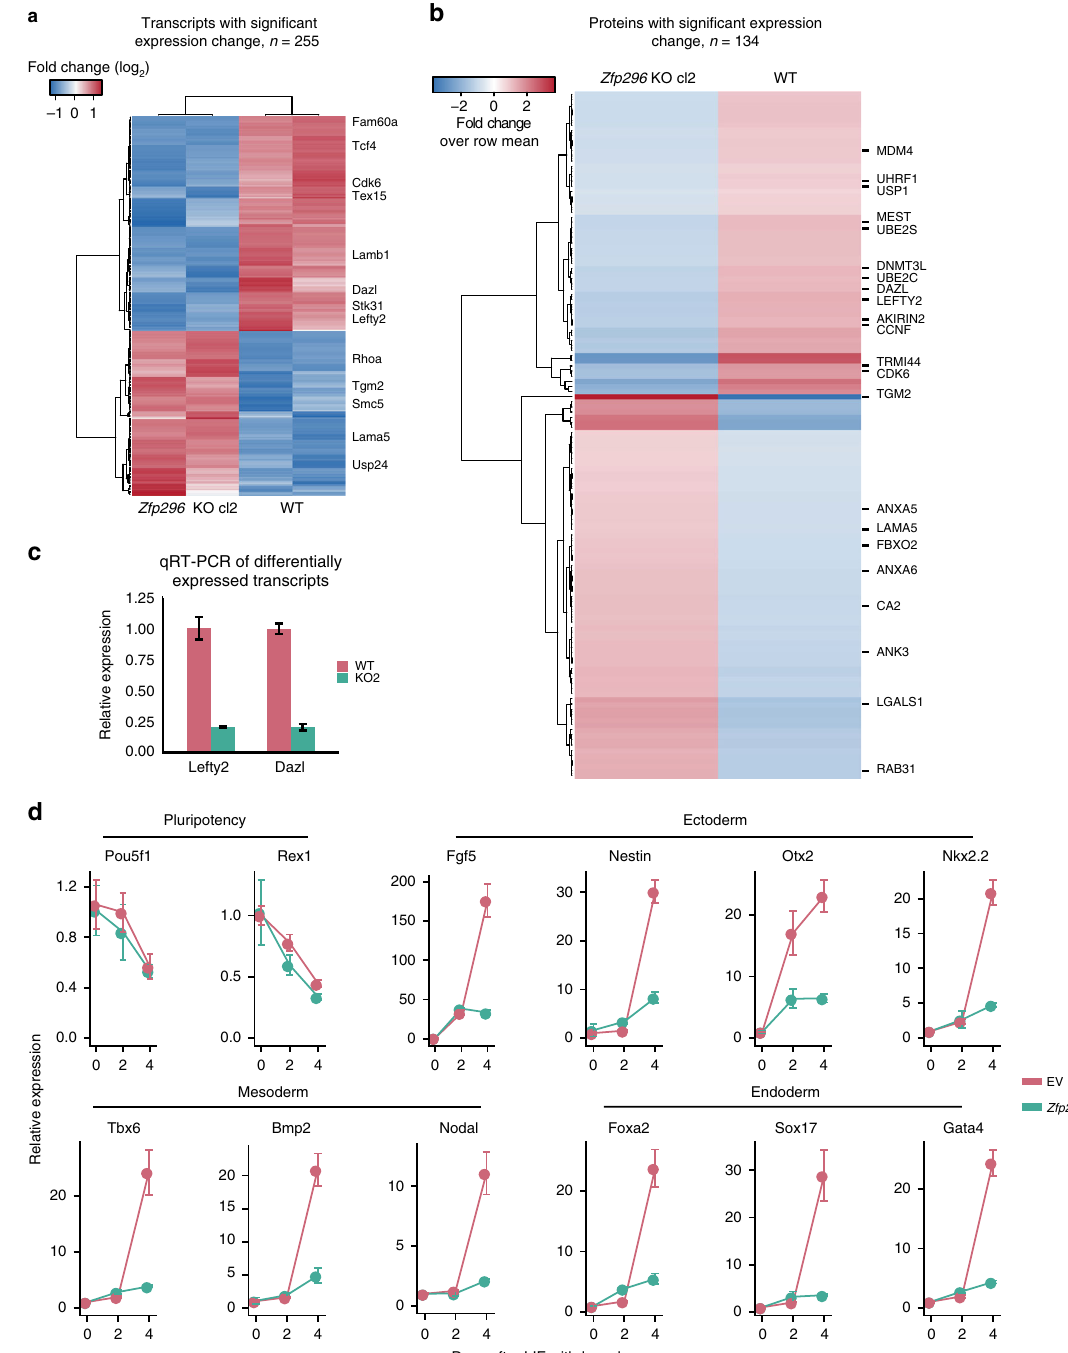
Fig. 5 Zfp296 knockout does not affect steady-state gene expression but impairs ESC differentiation. a Hierarchical clustering of differentially expressed genes (padj < 0.05) in Zfp296 KO clone 2 ESCs compared to wild-type (WT) ESCs. b Hierarchical clustering of differentially expressed proteins in Zfp296 KO clone 2 ESCs compared to WT ESCs. c qRT-PCR validation of differentially expressed transcripts in WT and Zfp296 KO clone 2 ESCs. n = 2 RNA isolations, error bars = s.d. of technical triplicates from one experiment. d qRT-PCR analysis of expression levels of pluripotency and differentiation markers during an embryoid body (LIF withdrawal) time course using WT and Zfp296 KO clone 2 ESCs. n = 4 time courses, error bars = s.d. of technical triplicates from one (PX459; Addgene 48139). The resulting plasmid was veri fi ed by sequencing and Chromatin preparation . Attached ESCs and NPCs were cross-linked with 1% transfected into R1 ESCs. After two days, the cells were subjected to puromycin formaldehyde for 10 min at room temperature with gentle shaking. Cross-linking selection for 48h, then monoclonal cell lines were generated and analyzed by was quenched with the addition of 1/10 volume 1.25 M glycine. Cells were washed sequencing. with PBS, then harvested by scraping in Buffer B (20 mM HEPES, 0.25% Triton X- Wild-type and Zfp296 KO ESCs were differentiated into embryoid bodies by 100, 10 mM EDTA, and 0.5mM EGTA). Cells were pelleted by spinning at 600× g plating 2× 10 5 cells/mL of media onto non-adherent plates in the absence of LIF. for 5min at 4 °C. Cell pellet was resuspended in Buffer C (150mM NaCl, 50mM The medium was changed daily during the differentiation to embryoid bodies. HEPES, 1mM EDTA, and 0.5mM EGTA) and rotated for 10 min at 4 °C. Cells